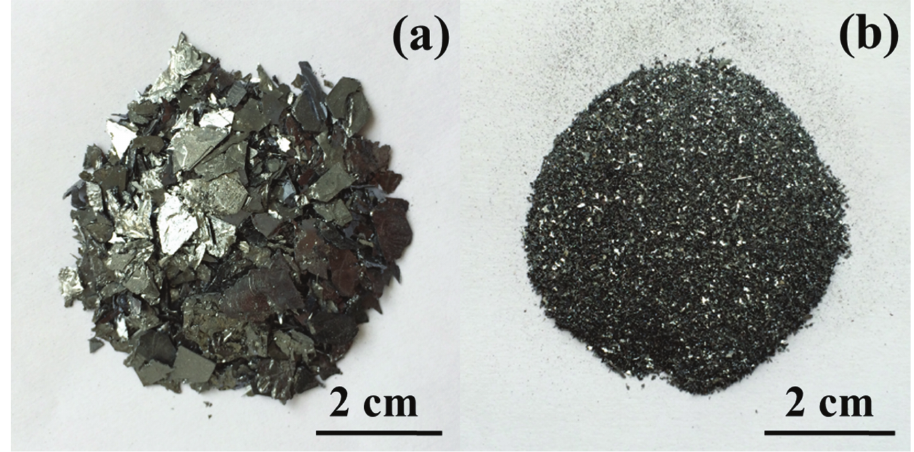
Figure 4: The morphology of primary silicon flakes and eutectic silicon powder, (a) primary silicon flakes, (b) eutectic silicon